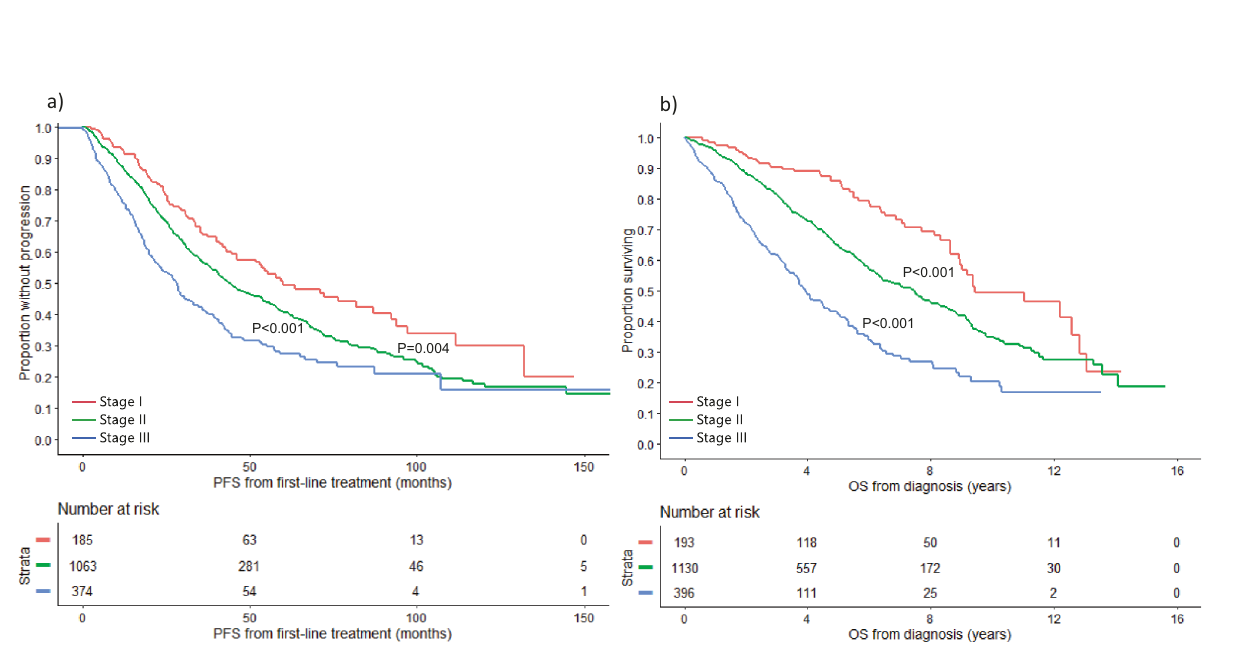
Univariate and multivariate analysis including cytogenetic abnormalities, ISS stage and LDH. Del deletion, HR high-risk, IgH immunoglobulin heavy chain gene locus, ISS international staging system, LDH lactate dehydrogenase, OS overall survival, RR risk ratio. Bolded numbers represent P values <0.05.